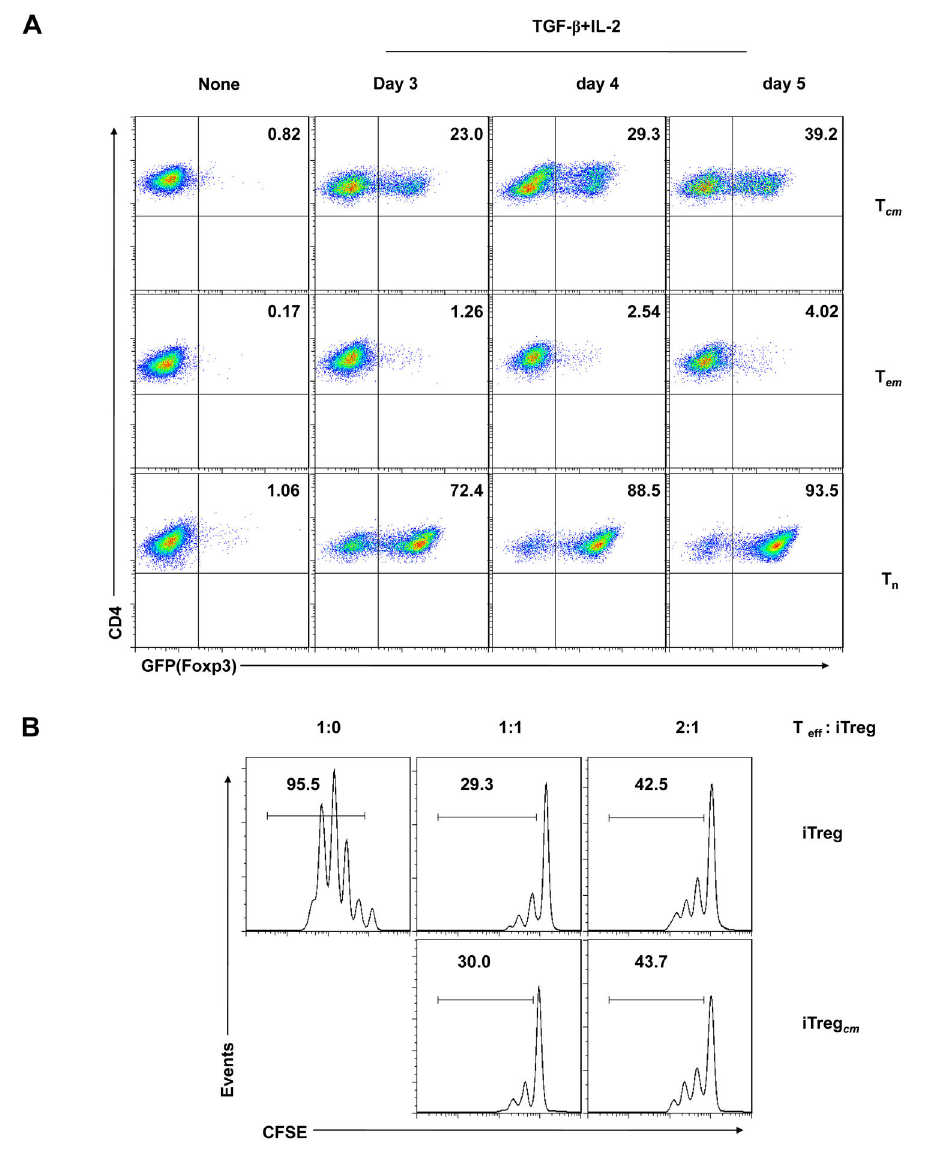
Figure 5. Induction of functional Foxp3 + T cells from mouse CD4 + CD62L + central memory T cells. (A) FACS-sorted mouse CD4 naive T cells (Tn), CD4 central memory T cells (T ) and CD4 effector memory T cells (T ) were stimulated in vitro (1×10 5 cm em cells/well) with anti-CD3 (2 μg/ml) and APCs (1×10 5 cells/well) in the presence of TGF-β (3 ng/ml) and IL-2 (100 U/ml) for 3–5 days. The induction of Foxp3 in the CD4 + fraction was analysed by FACS based on GFP expression. (B) CD4 + GFP - (Foxp3 - ) T cells were sorted from Foxp3 gfp mice, labelled with CFSE and used as responder cells. The labelled T cells (1×10 5 cells/well) were mixed with varying numbers of GFP + (Foxp3 + ) T cells to achieve the desired Foxp3 + T cells/T effector cell ratios. GFP + (Foxp3 + ) T cells were sorted from CD4 + naive or central memory T cells through the induction of Foxp3. ‘iTreg’ indicates in vitro TGF-β-induced GFP + cells from CD4 + naive T cells, and ‘iTreg ’ indicates in vitro TGF-β-induced GFP + cells from cm CD4 + CD62L + central memory T cells. The cell mixture was stimulated with syngeneic APCs (1×10 5 cells/well) and soluble anti-CD3 (1 μg/ml). Responder T cell proliferation with or without Foxp3 + T cells was assessed by CFSE dilution after 3 days of culture. The results are one representative of three independent experiments.